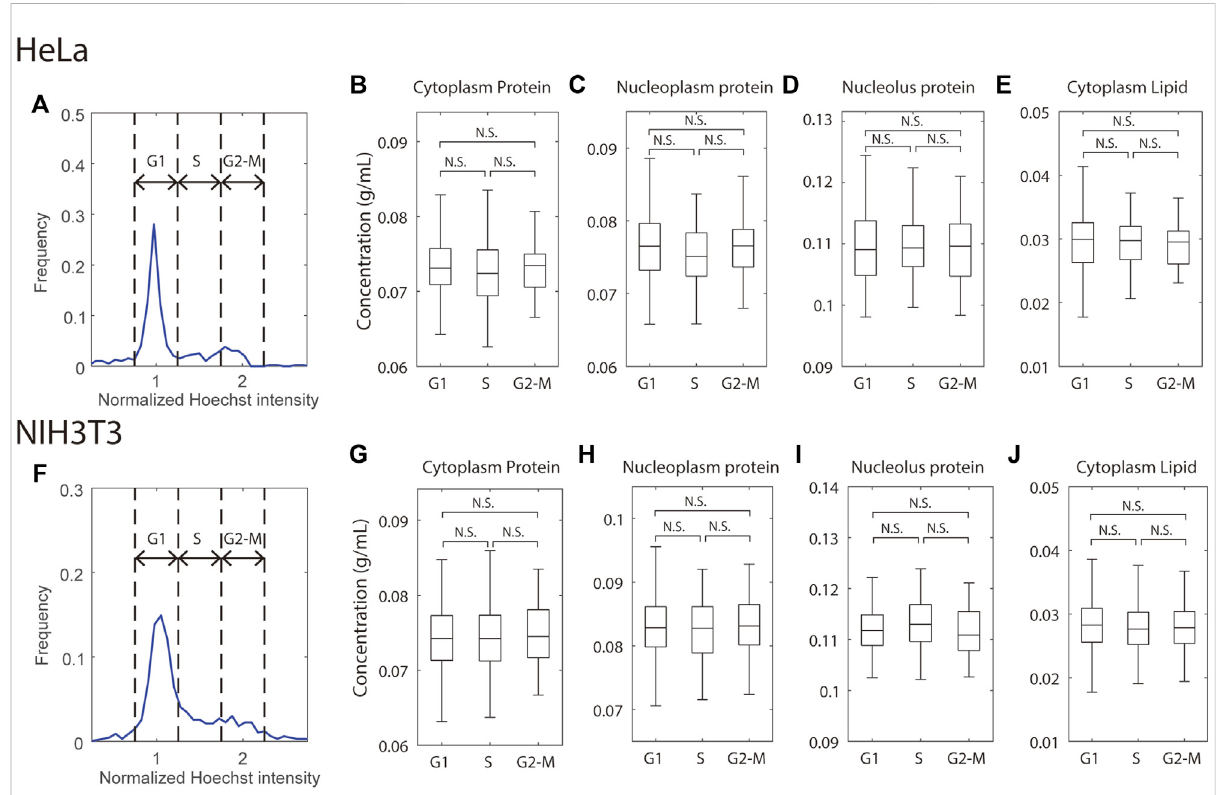
FIGURE 3 Massdensitiesareindependent ofthecellcycle. (A,F) HistogramoftotalHoechstintensityinthenucleusincyclingHeLa (A) orNIH3T3 (F) cells; the Hoechst intensity was normalized to the G1 peak of the distribution. Dashed lines indicate the gates for G1, S, and G2-M cells. (B – E,G – J) Mass densities in HeLa (B – E) and NIH3T3 (G – J) cells, grouped by the cell cycle stages. n = 250 (HeLa G1), 53 (HeLa S), 53 (HeLa G2-M), 392 (NIH3T3 G1), 123 (NIH3T3 S), 95 (NIH3T3